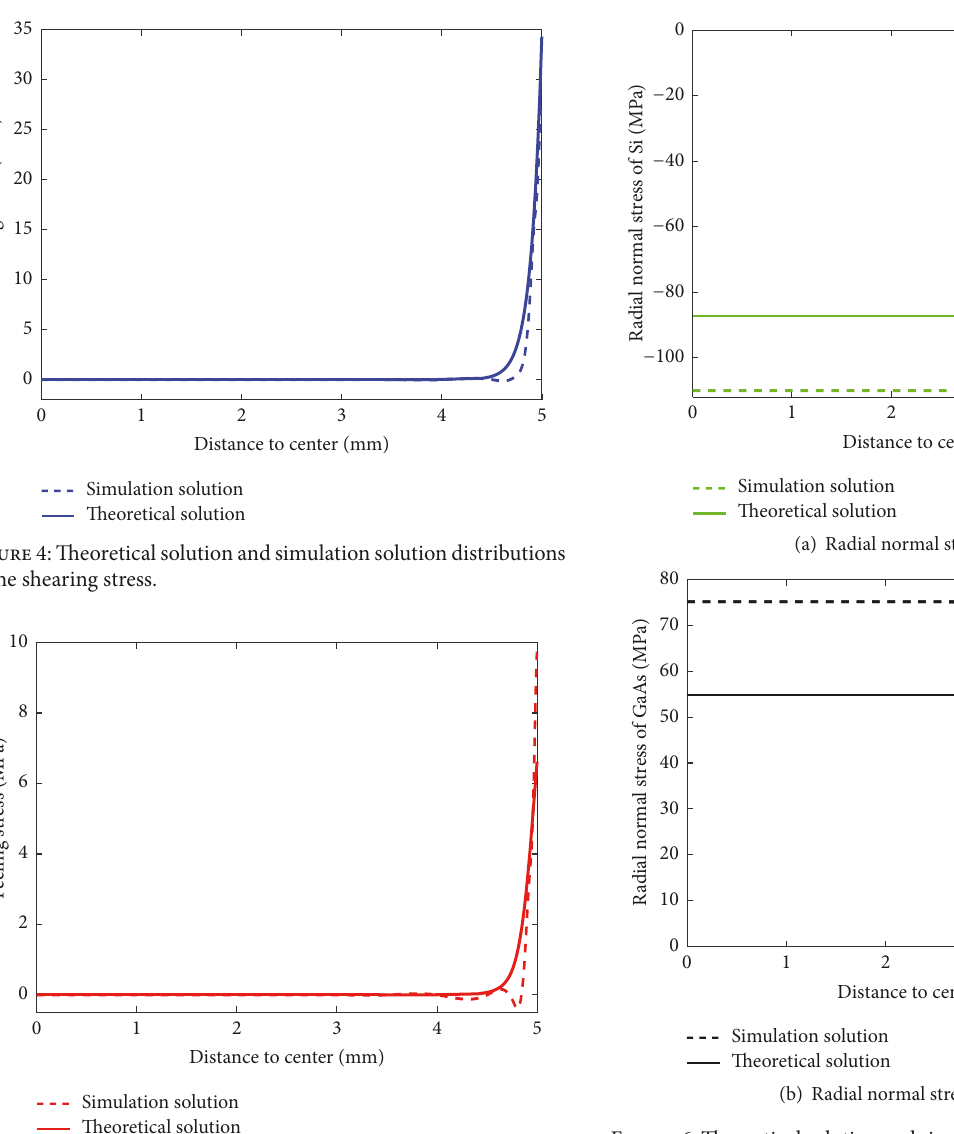
Figure 5: Theoretical solution and simulation solution distributions of the peeling stress.